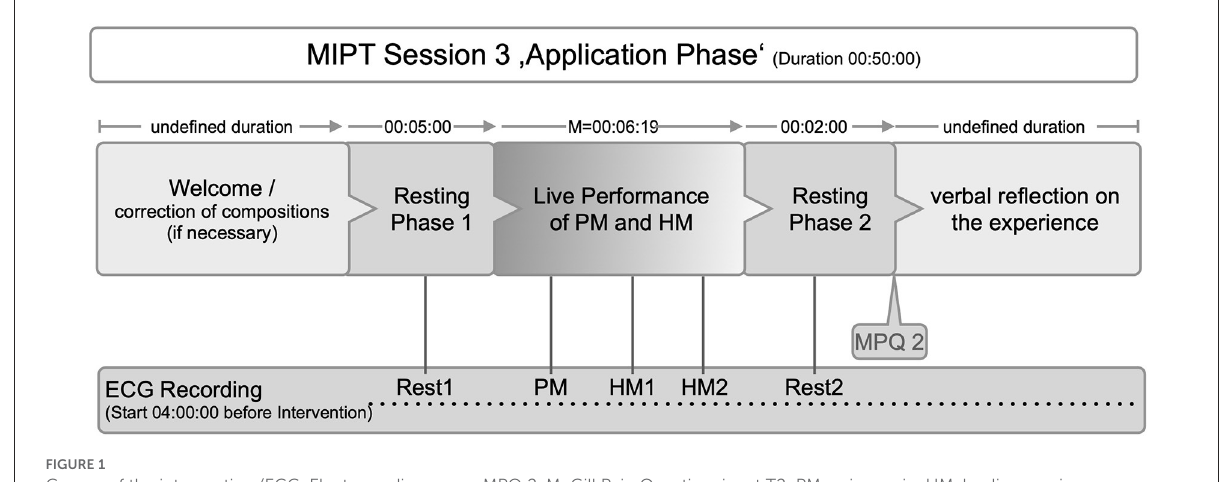
FIGURE1 Course of the intervention (ECG, Electrocardiogramm; MPQ 2, McGill Pain Questionaire at T2; PM, pain music; HM, healing music; Rest1/PM/HM1/HM2/Rest2, time points for HRV